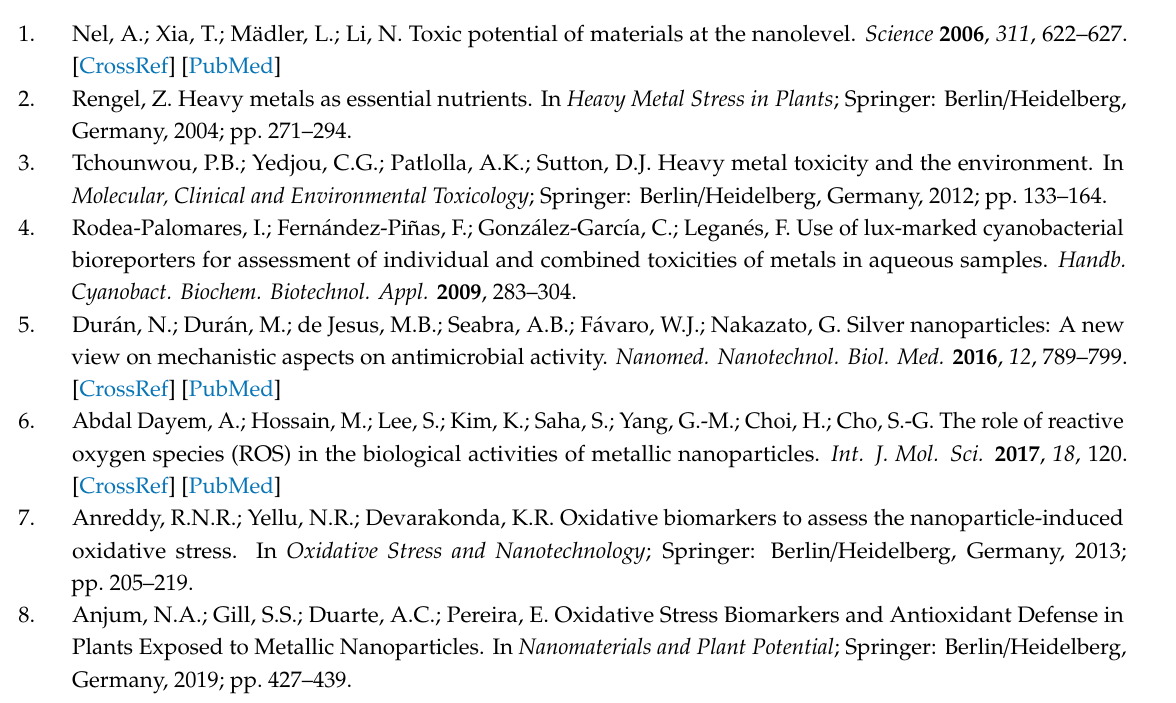
Figure S1: Dose-Response curves of the bioluminescence of Nostoc sp. CPB4337 after 24 h of exposure to increasing concentrations of metallic NPs, Figure S2: Bioluminescence induction of ROS-detecting Nostoc sp. PCC7120 bioreporters exposed to 0, 5, 15 and 20 mg / L of CuO NPs after 1, 6 and 24 h of exposure, Table S1: Dissolved free-ions concentration released from each metallic NP as calculated by TXRF after 24 h of exposure in AA / 8 + N medium and percentage of released free-ion metals with respect to the nominal NP